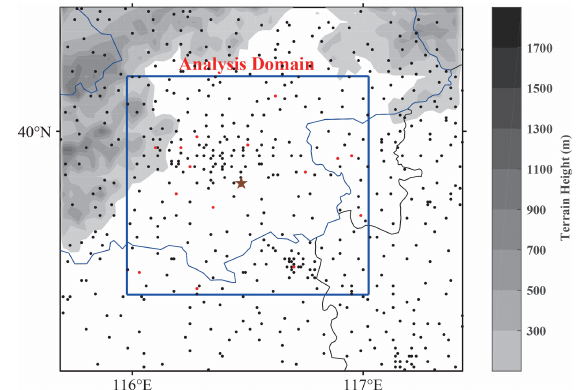
Figure 13. Objective analysis domain (blue box), terrain height (shaded), the distribution of surface stations (black and red dots with the red dots representing the surface stations with pressure measure- ments) and Beijing radar station (star). The boundary of Beijing is shown with the blue